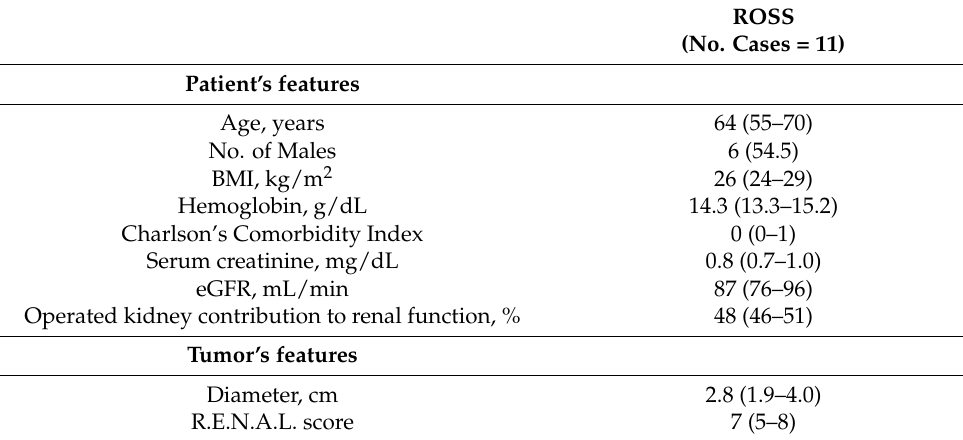
Table 1. Distribution of baseline characteristics of